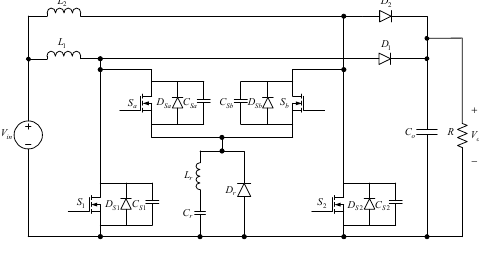
Figure 1. Proposed circuit.